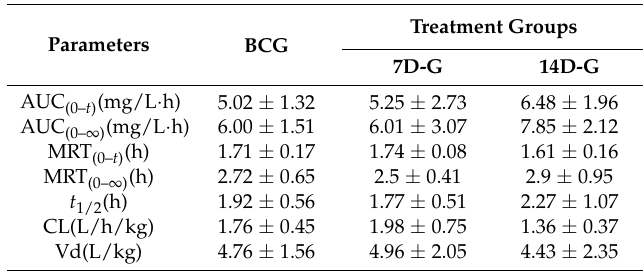
Table 4. Effects of SGI on pharmacokinetic parameter of metoprolol (10.0